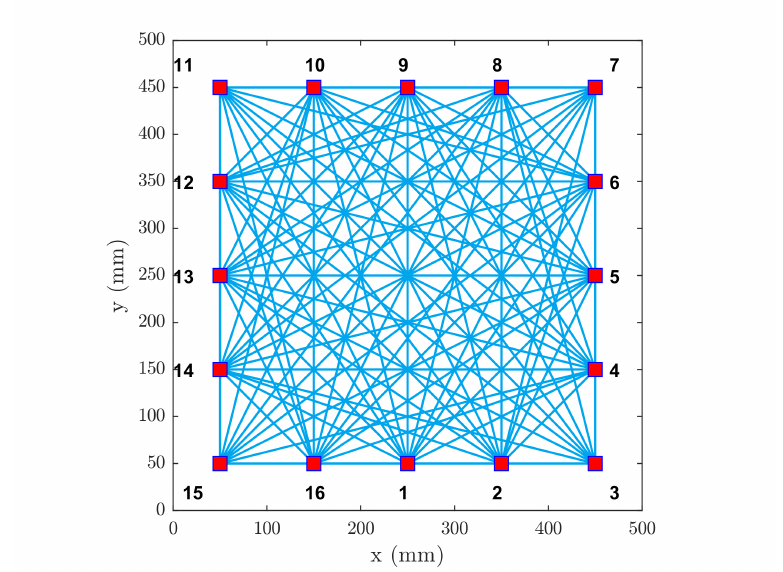
Figure 1. Array coverage with 16